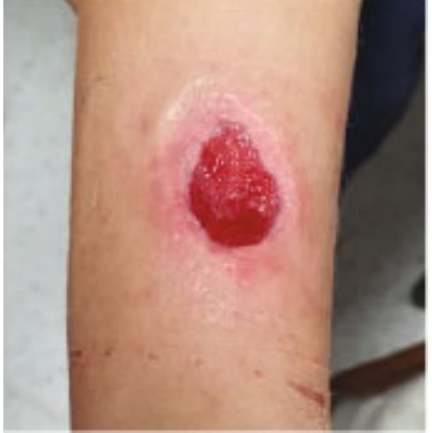
Figure 1: Debrided mass from the right leg.